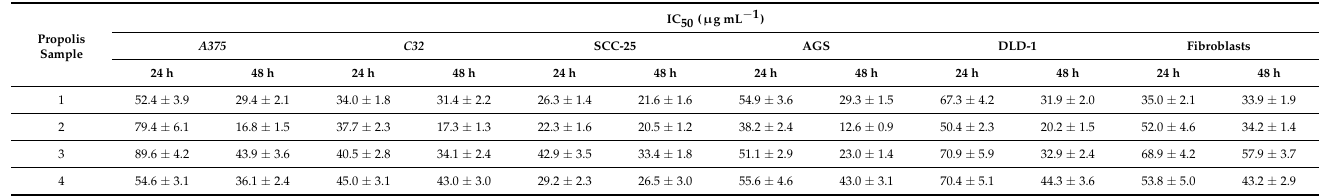
Table 4. IC 50 values of propolis extracts 1–4 for fibroblasts and selected cancer cell lines after 24 and 48 h of